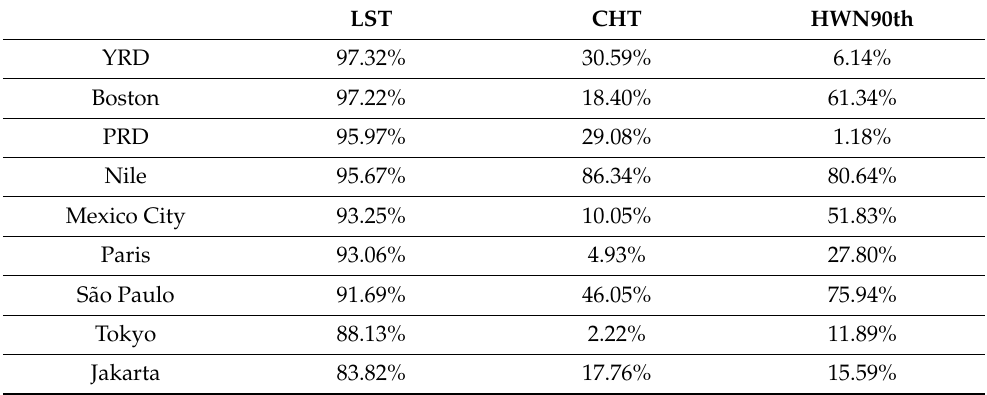
Table 2. The largest proportion of UHI hotspot magnitude based on different UHI and UHW